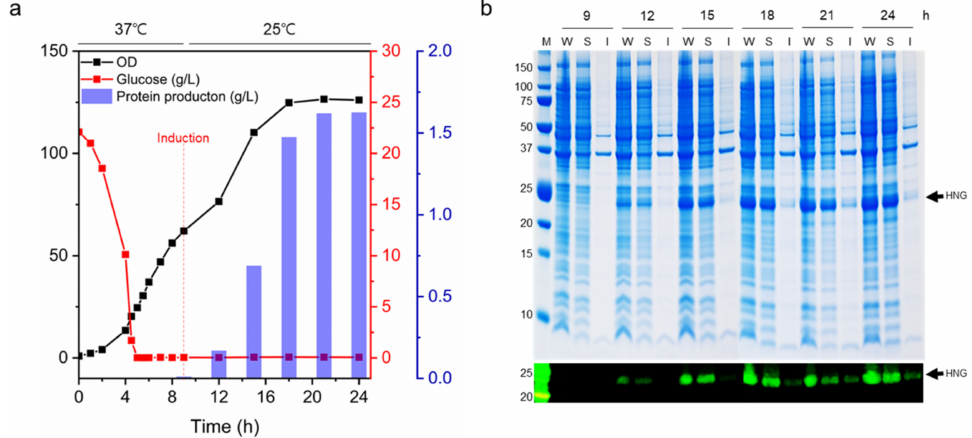
Figure 3. Fed-batch fermentation of E. coli BL21 (DE3)-pET21b-HNG. ( a ) E. coli fed-batch fermentation kinetics for the production of HNG. Cells were cultivated in batch mode until the initially present glucose was depleted. After 5 h, glucose feeding was initiated at a predefined rate. At an OD 600 of 62, protein expression was induced with 0.1 mM IPTG. Samples were collected to monitor cell OD 600 (black) and medium glucose content (red). ( b ) Culture samples collected at induction times of 9, 12, 15, 18, 21, and 24 h were analyzed using SDS-PAGE and Western blotting with an anti-His antibody. Lane M: protein molecular weight marker; Lane W: whole cell lysate; Lane S: soluble fraction; Lane I: insoluble fraction. The target protein is indicated by